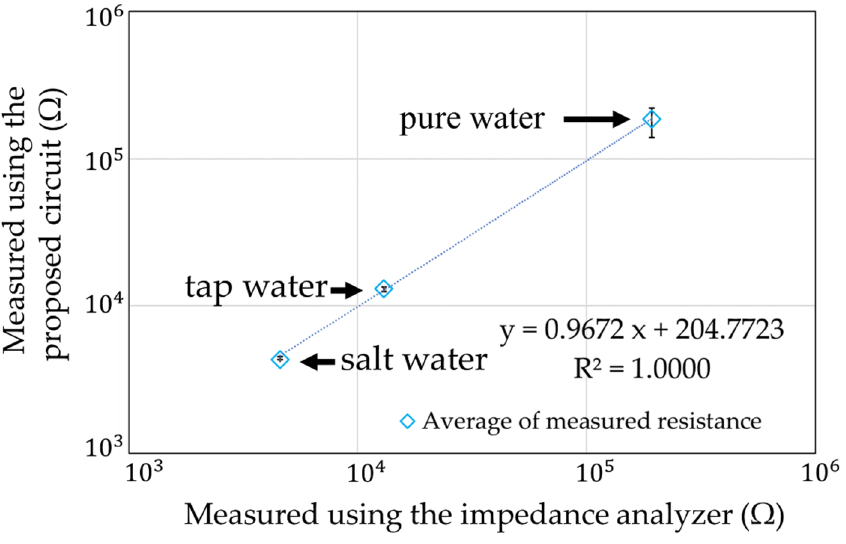
Figure 21. Measurement results of the ion concentration in water.